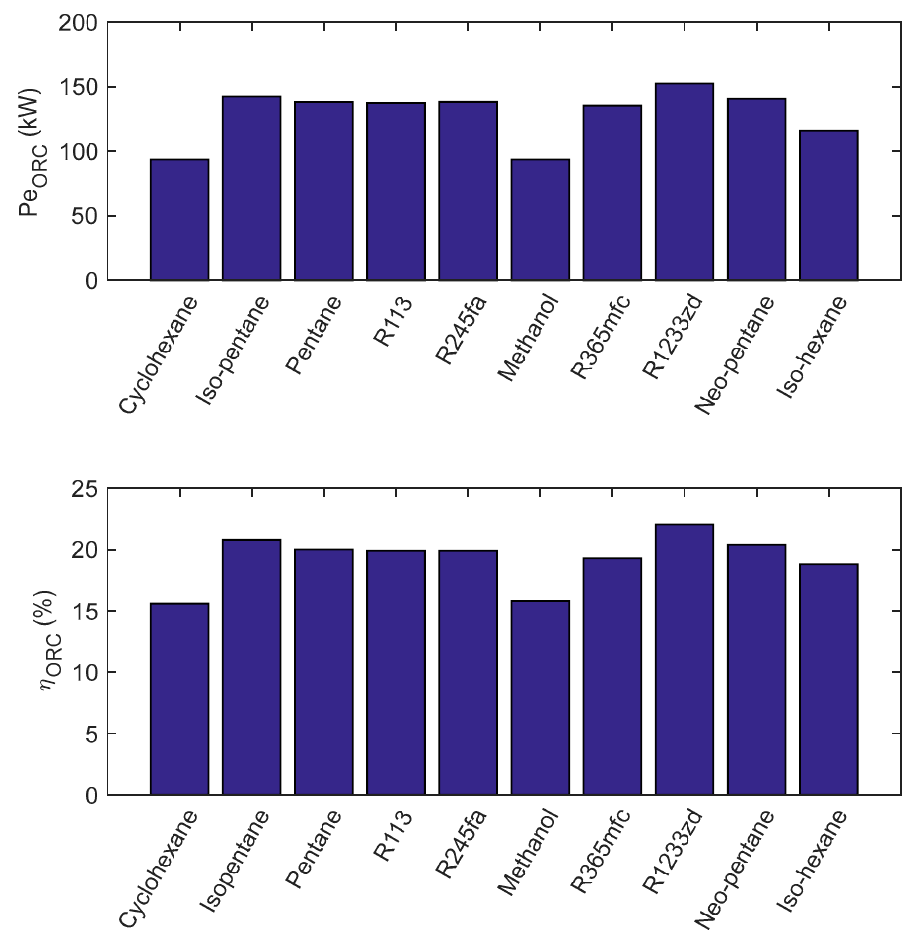
Figure 7. ORC electric power ( P e ) and thermal efficiency ( η ORC ) for the working fluids studied. Table 7. Optimum operating conditions for the ORC working fluids